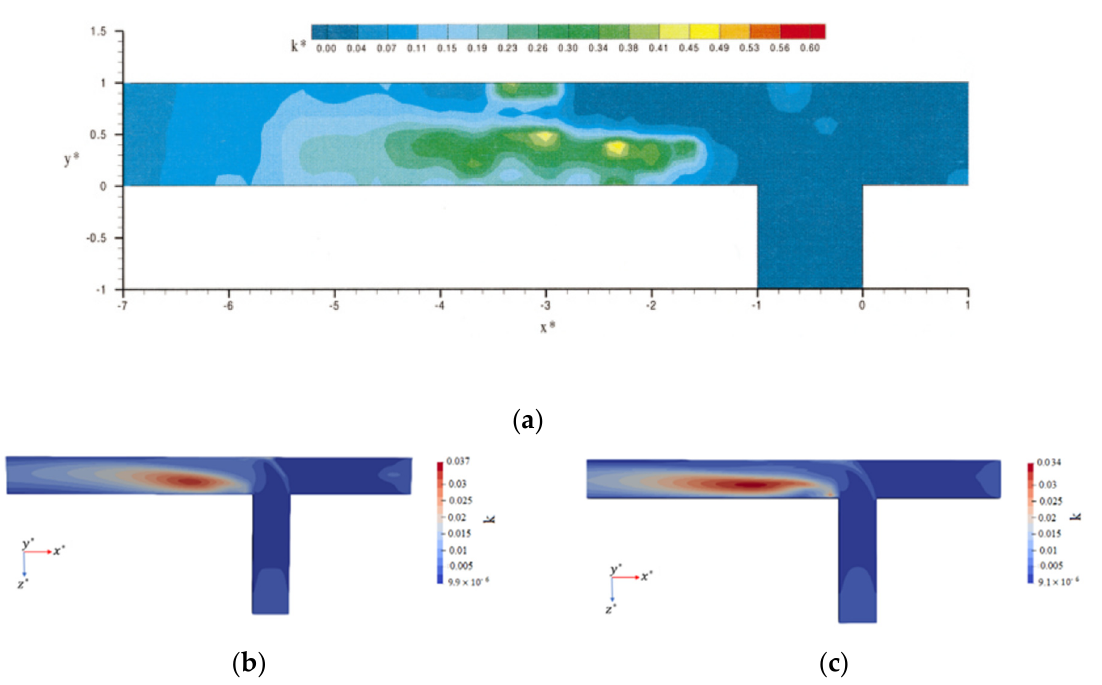
Figure 24. Turbulent kinetic energy distribution. ( a ) Dimensionless turbulent kinetic energy- experiment [19]; ( b ) Dimensionless turbulent kinetic energy- simulated (Standard k- ε ); ( c ) Dimensionless turbulent kinetic energy- simulated (Realizable k- ε ).